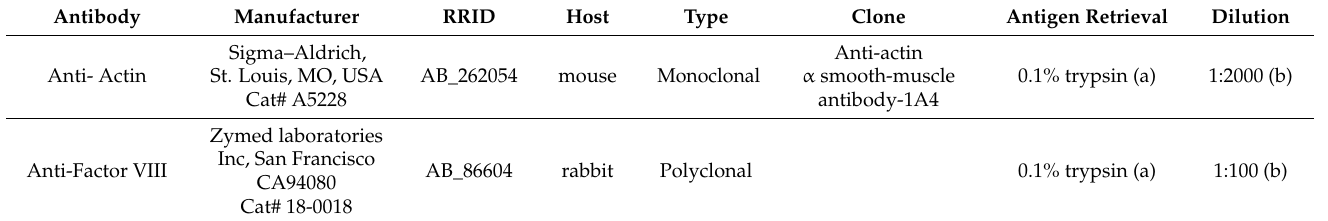
Table 2. Summary of immunohistochemical staining methodology. (a) 0.1%Tripsina, 60 min at 37